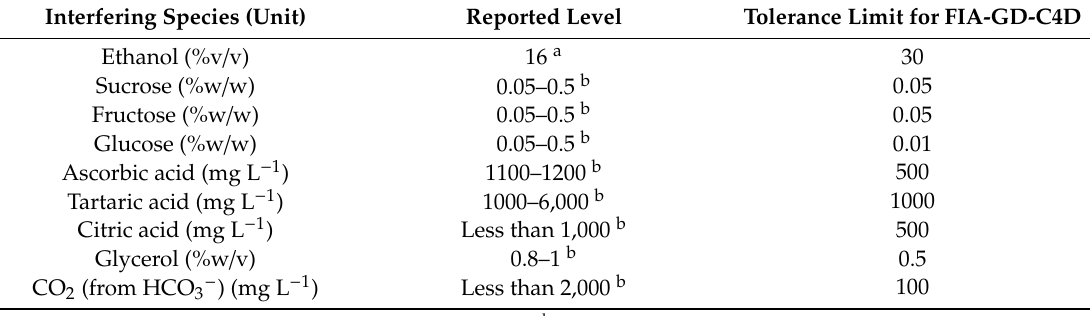
Table 1. Investigation of possible interfering species in wine for total sulfite analysis from triplicate injections of 25 mg L − 1 SO 32 − standard solution.